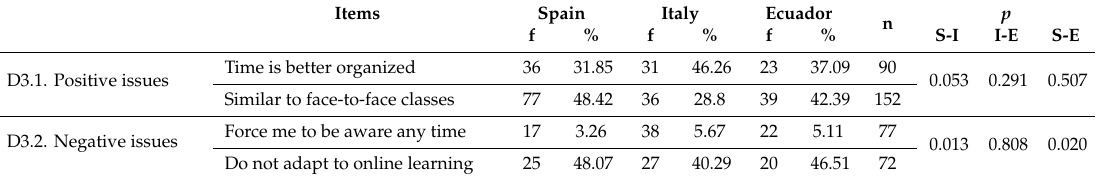
Table 4. Positive and negative aspects perceived by students among countries about teaching during lockdown.